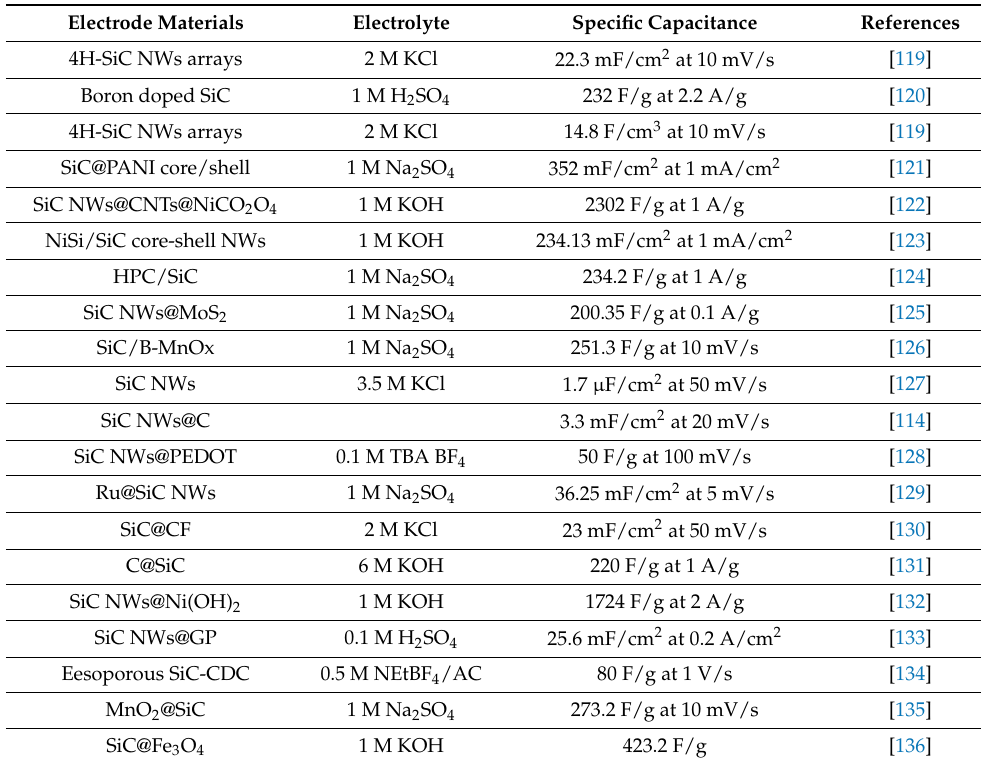
Table 3. Some SiC-based electrode materials and their electrochemical